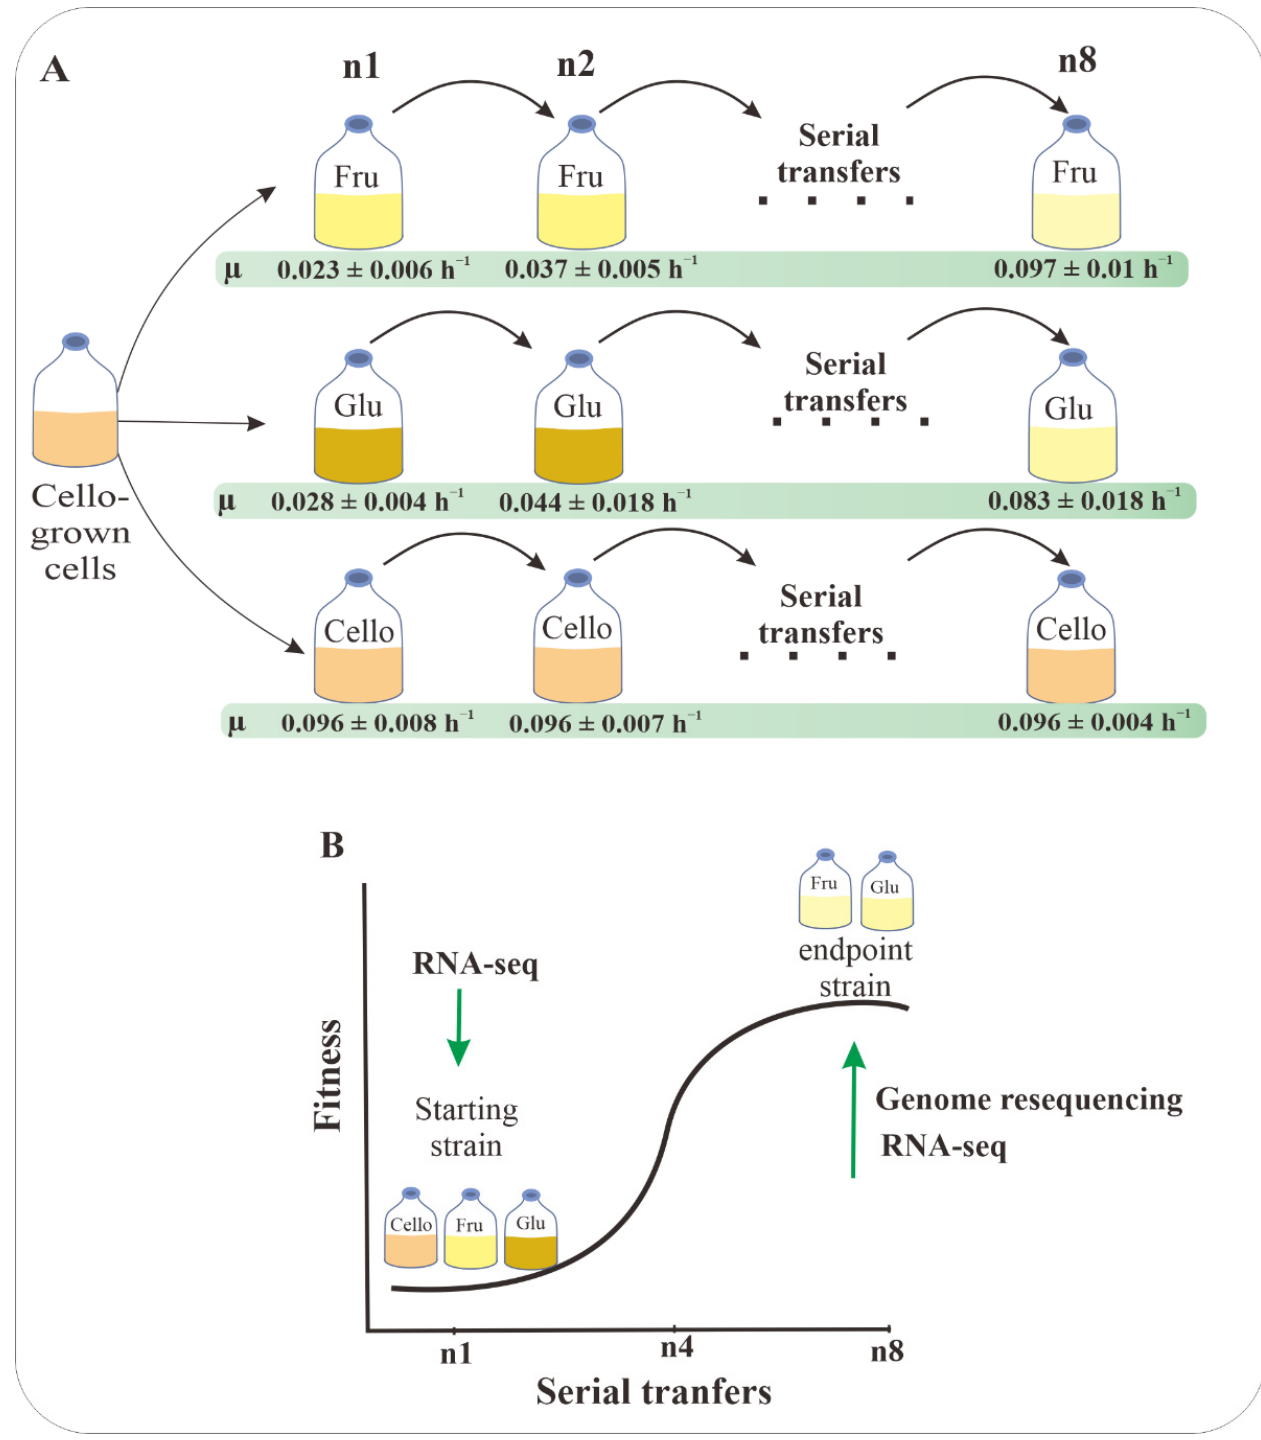
Figure 1. Schematic diagram of the present study. ( A ) Adaptive laboratory evolution was applied to FAs1 and GAs1 to improve their growth on fructose and glucose, respectively. After ~40 generations, growth rates of FAs8 and GAs8 were dramatically increased. ( B ) Starting strains FAs1, GAs1, and CGs1 at the late stationary phase were used for RNA-seq and the end-point strains FAs8, GAs8 were used for genomic analysis and RNA-seq.